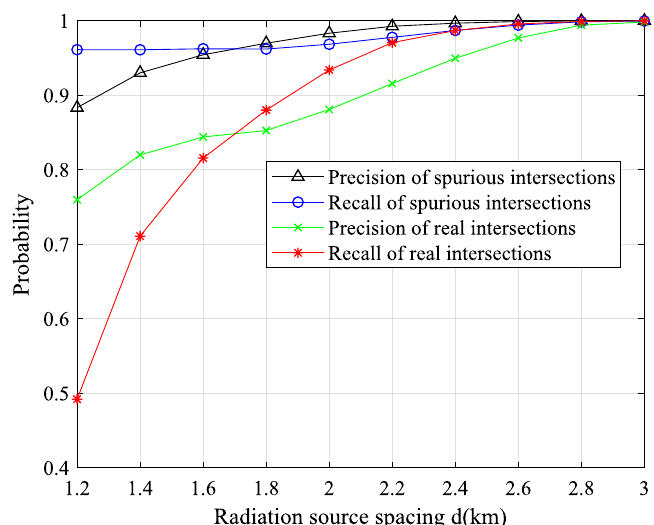
Fig. 7 Comparison of recall and precision versus radiation source spacing